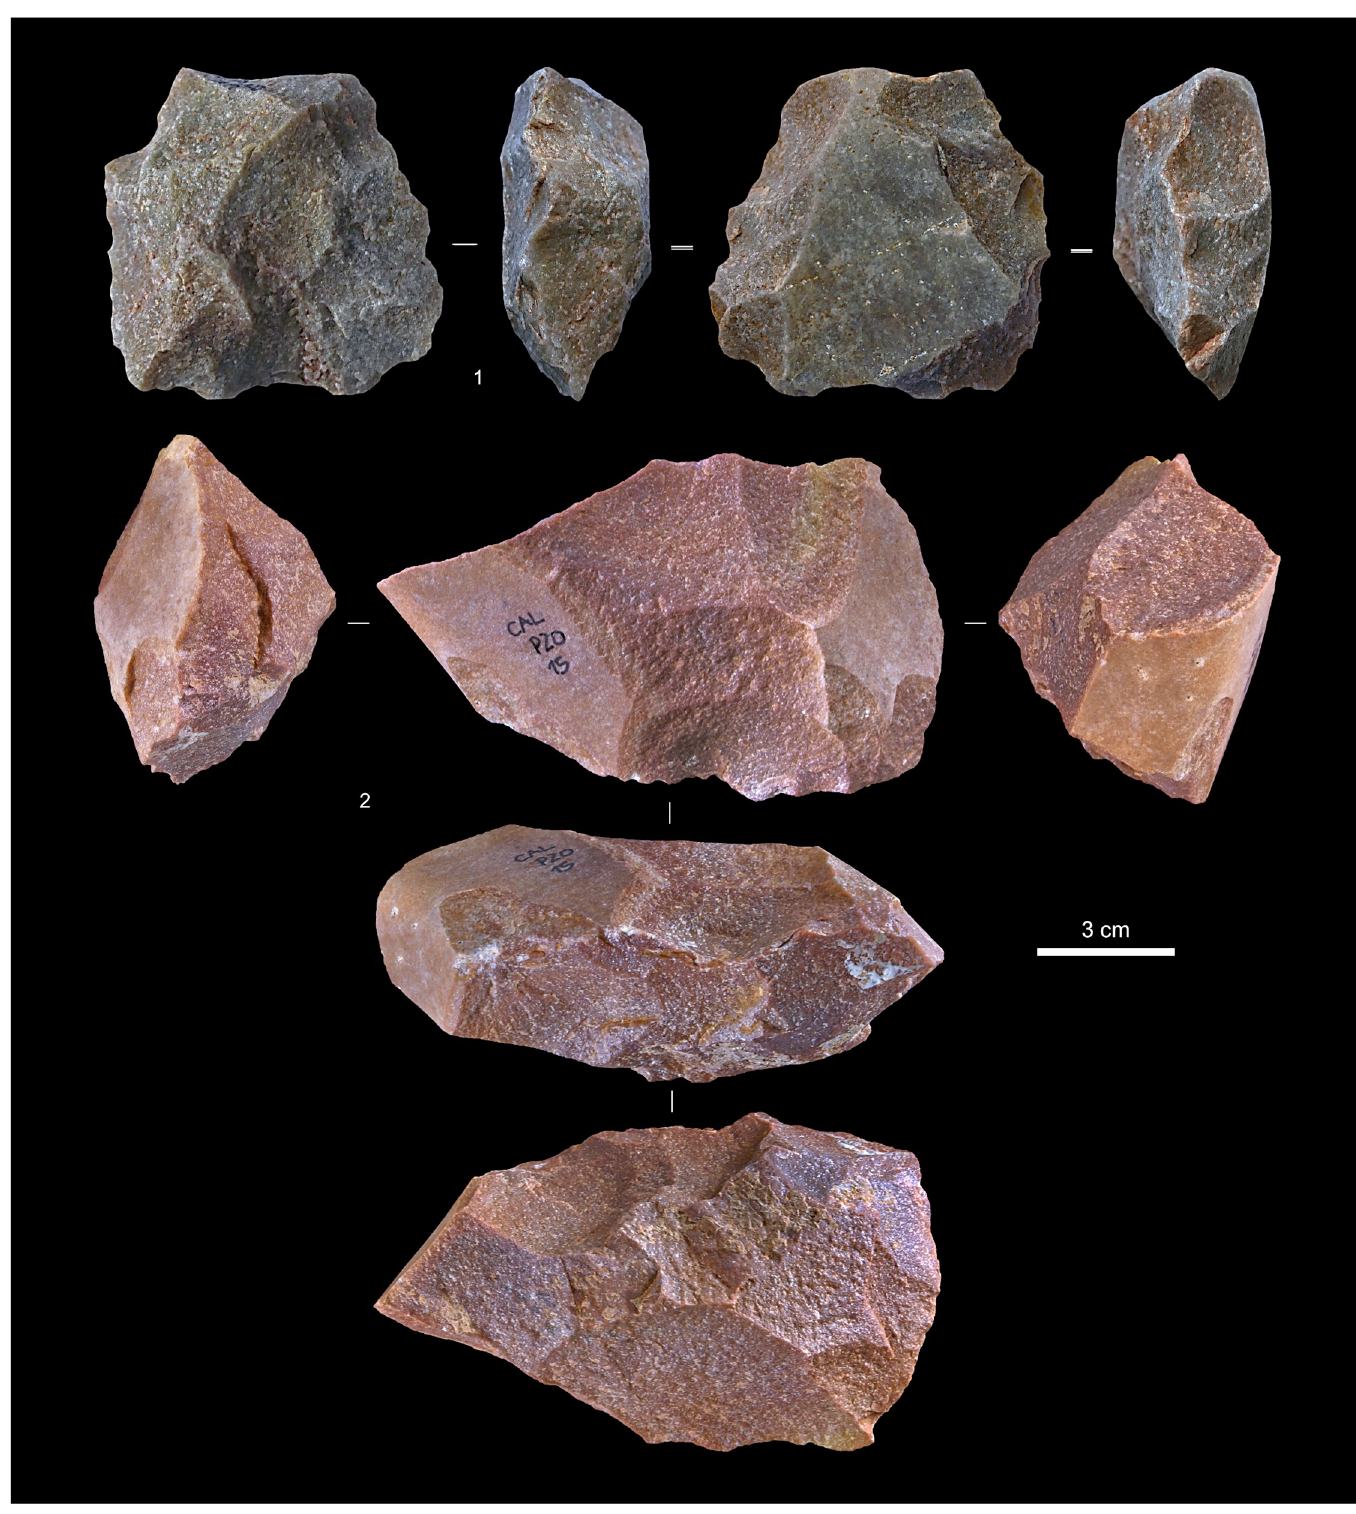
Fig 20. Entrance trench: Middle palaeolithic quartzite cores. 1. Centripetal Levallois core, exhausted (Unit 6, S20sc130). 2. Discoidal core, initial phase (set-up of the reduction surface) (Unit 5, P20-15).